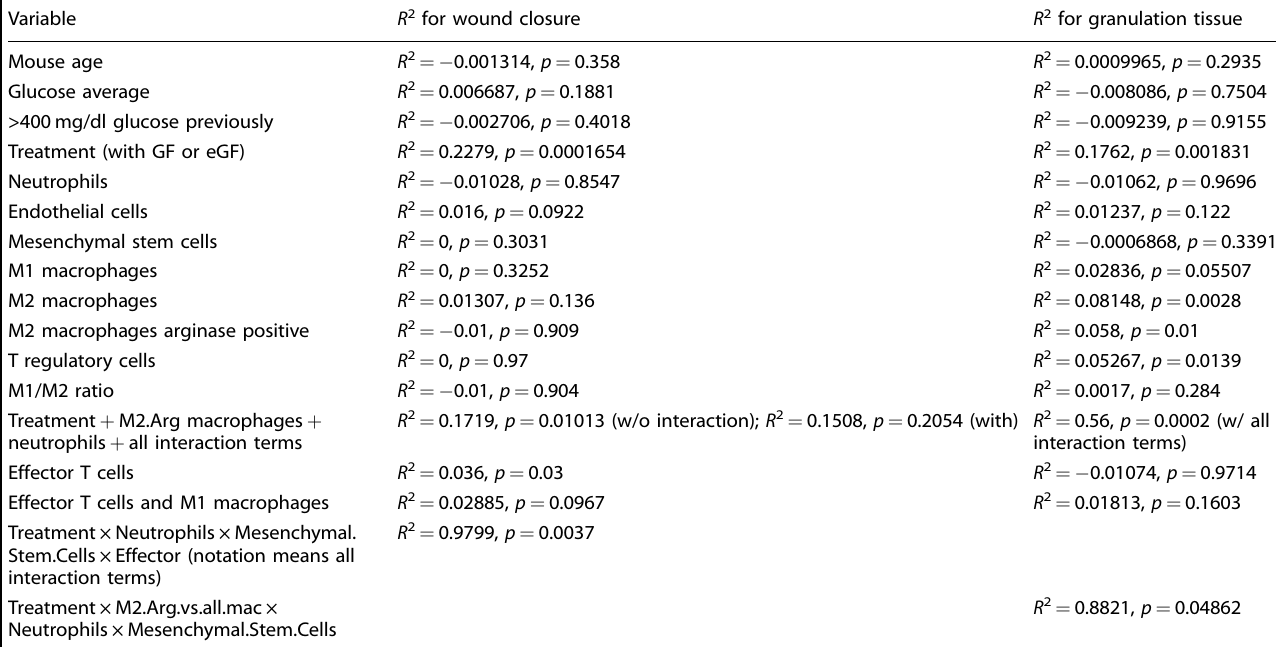
Table 1. Statistical comparison of cell number in wound, correlated with wound-healing outcome. Variable R 2 for wound closure R 2 for granulation